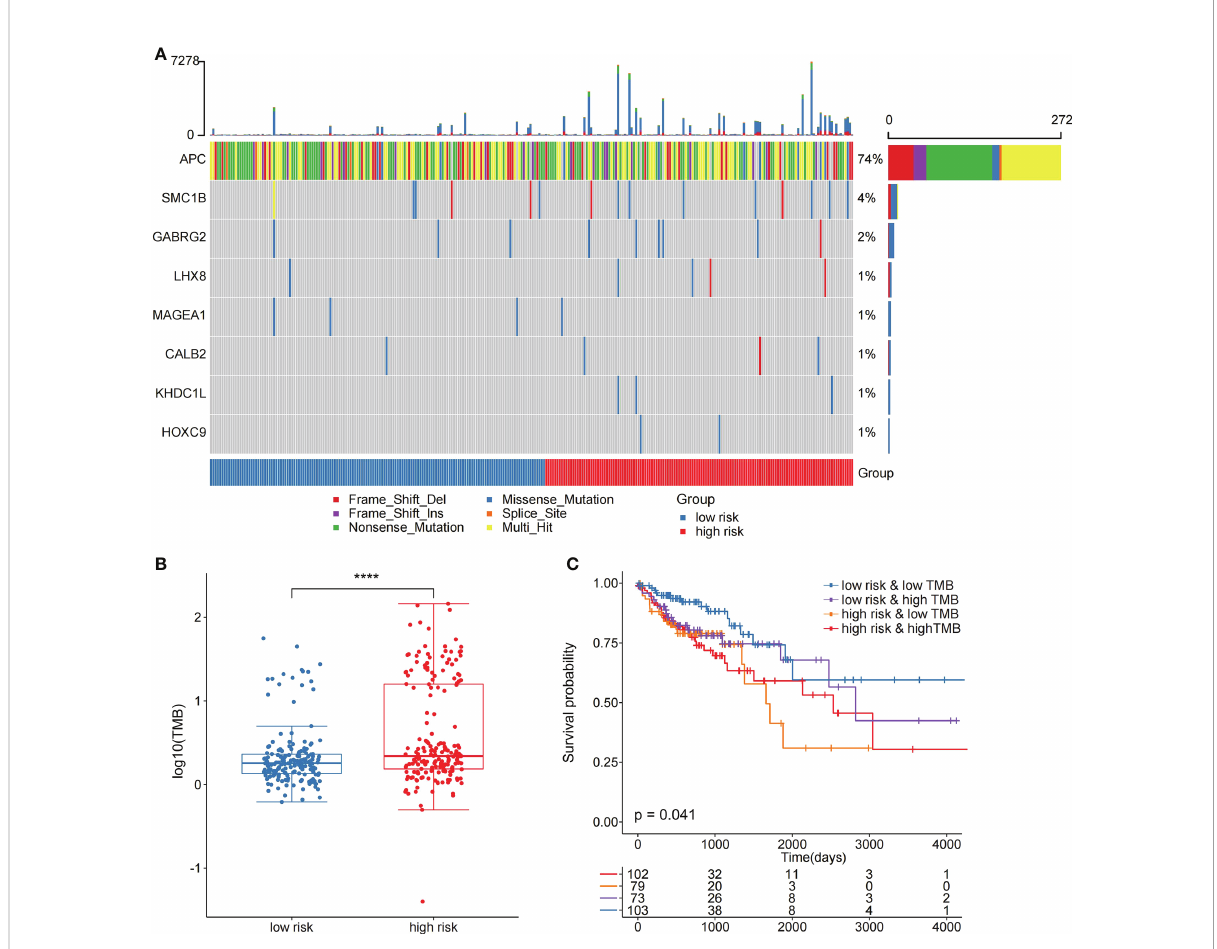
FIGURE 7 The two risk groups have different mutation features. (A) Somatic mutation features of the two risk groups. (B) TMB was compared between the two risk groups (C) Comparison of patient outcome of low-risk and low TMB group, low-risk and high TMB group, high-risk and low TMB group, and high-risk and high TMB